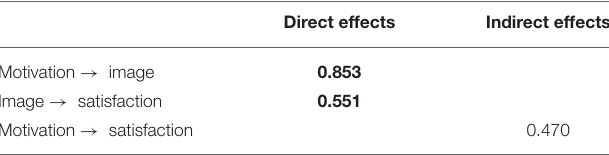
TABLE 10 | Direct and indirect effects of the coefficients.